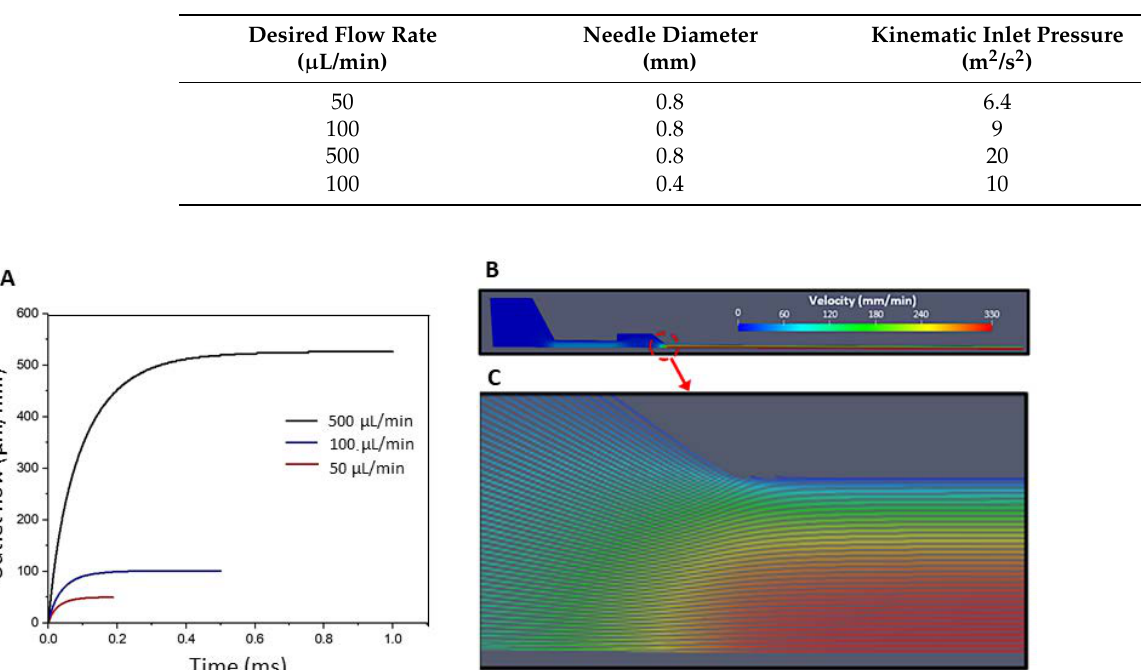
Table 2. Inlet pressure used to achieve different flow rates.